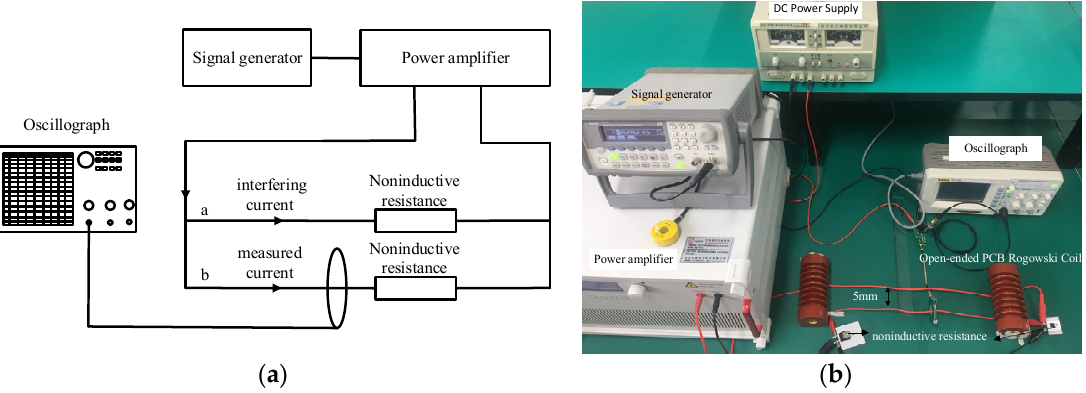
Figure 14. Test platform for external magnetic field interference of open-ended Rogowski coil. ( a ) Schematic diagram; ( b ) Field diagram.